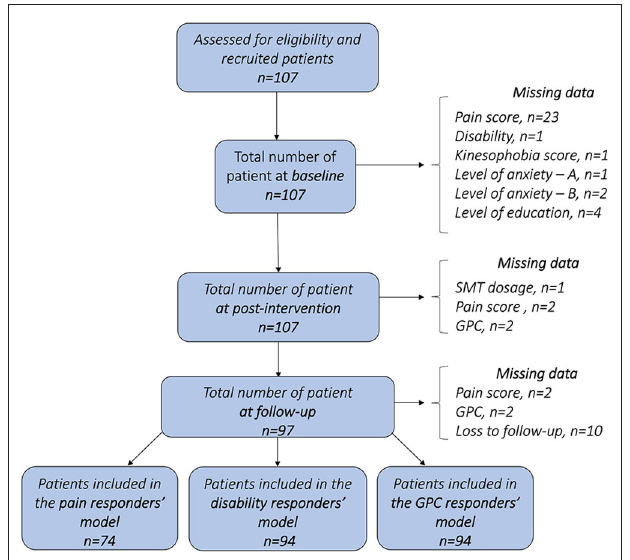
FIGURE 2 | Flow diagram of included patients and data, at each measurement time point. One given patient may have missing data for one outcome and still be included in the next stages of the study. (GPC = Global Perceived Change; SMT = Spinal Manipulative Therapy).